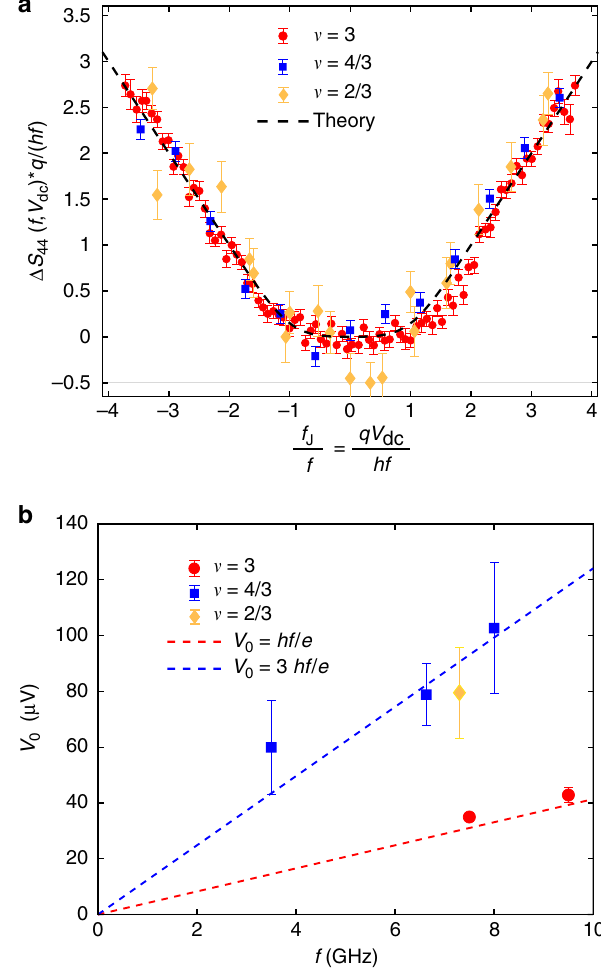
0 Fig. 4 The characteristic frequency for fractional quasiparticle transfer. as a function of the a High frequency noise measurements q Δ S 44 ð f ; qV dc = ð hf ÞÞ hf ratio of the characteristic Josephson frequency f J = qV dc / h with the measurement frequency f . We take q = e for ν = 3 and q = e /3 for ν = 4/3 þ x (cid:3) 1 (cid:3) coth 1 and ν = 2/3. The black dashed line is x þ 1 coth x þ 1 coth x (cid:3) 1 2 2 x T 2 2 x T 2 x T (cid:4) 0 : 15 is the electronic temperature in renormalized units. where x T ¼ k B T hf Error bars are de fi ned as standard error of the mean. b Emission threshold V 0 for the three fi lling factors as a function of the measurement frequency f . The blue dashed line is V 0 = 3 hf / e . The red dashed line is V 0 = hf / e . Error bars represent the 68 percent con fi dence interval fractional case fall on the blue dashed line V 0 = 3 hf / e correspond- ing to quasiparticle transfer with charge q = e /3.